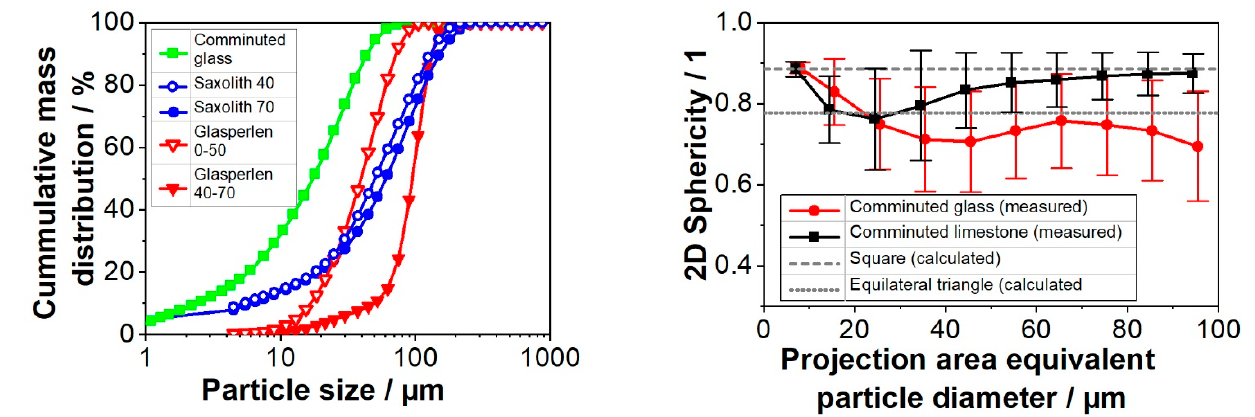
Figure 2. Particle size distributions of the used materials ( left ). “Saxolith” corresponds to the comminuted limestone and “Glasperlen” to the glass beads. The 2D sphericity of the comminuted materials is shown on the ( right ) side. The points are slightly offset, to enhance the visibility of the error bars, which indicate one standard deviation determined by a sample of at least 1000 particles per 10 µ m size interval. The connecting line between the points is a guide for the eye.